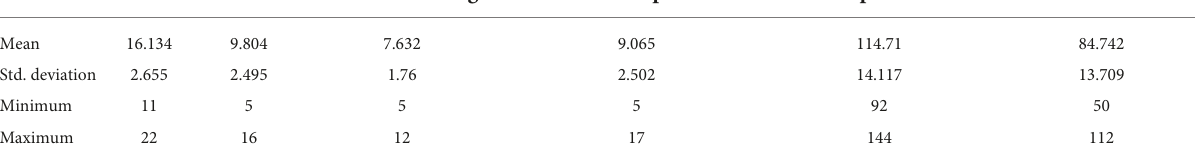
TABLE 3 Questionnaire